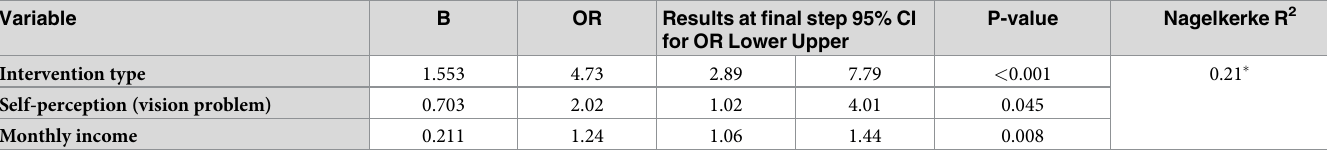
Table 6. Multivariate binary logistic regression of the predictors of participants’ referral compliance.